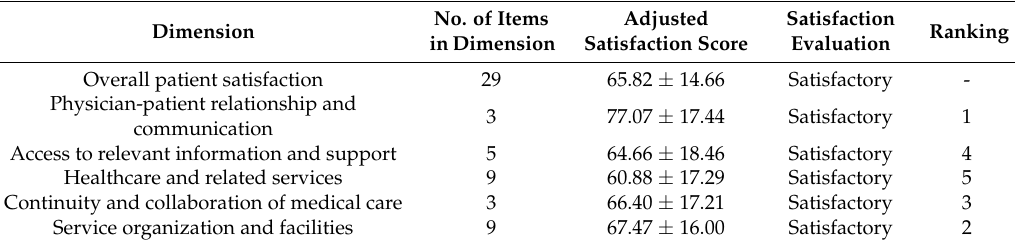
Table 3. Patient satisfaction and evaluation.